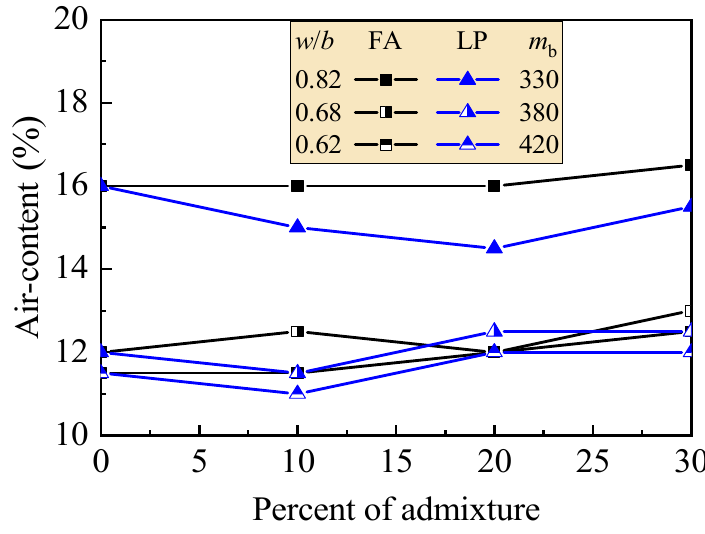
Figure 3. Test results of the air content of fresh mortars.